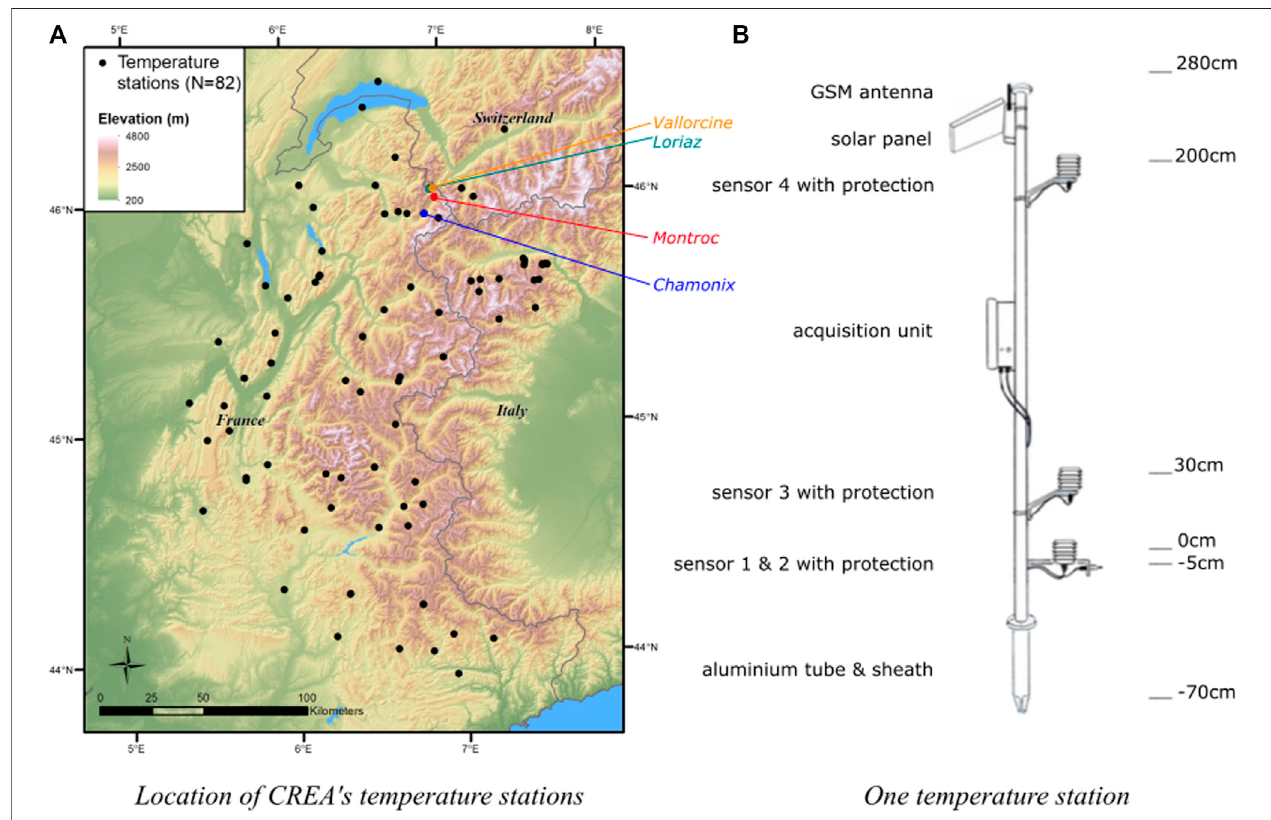
FIGURE 1 | Location of the stations (A) and description of their components (B)